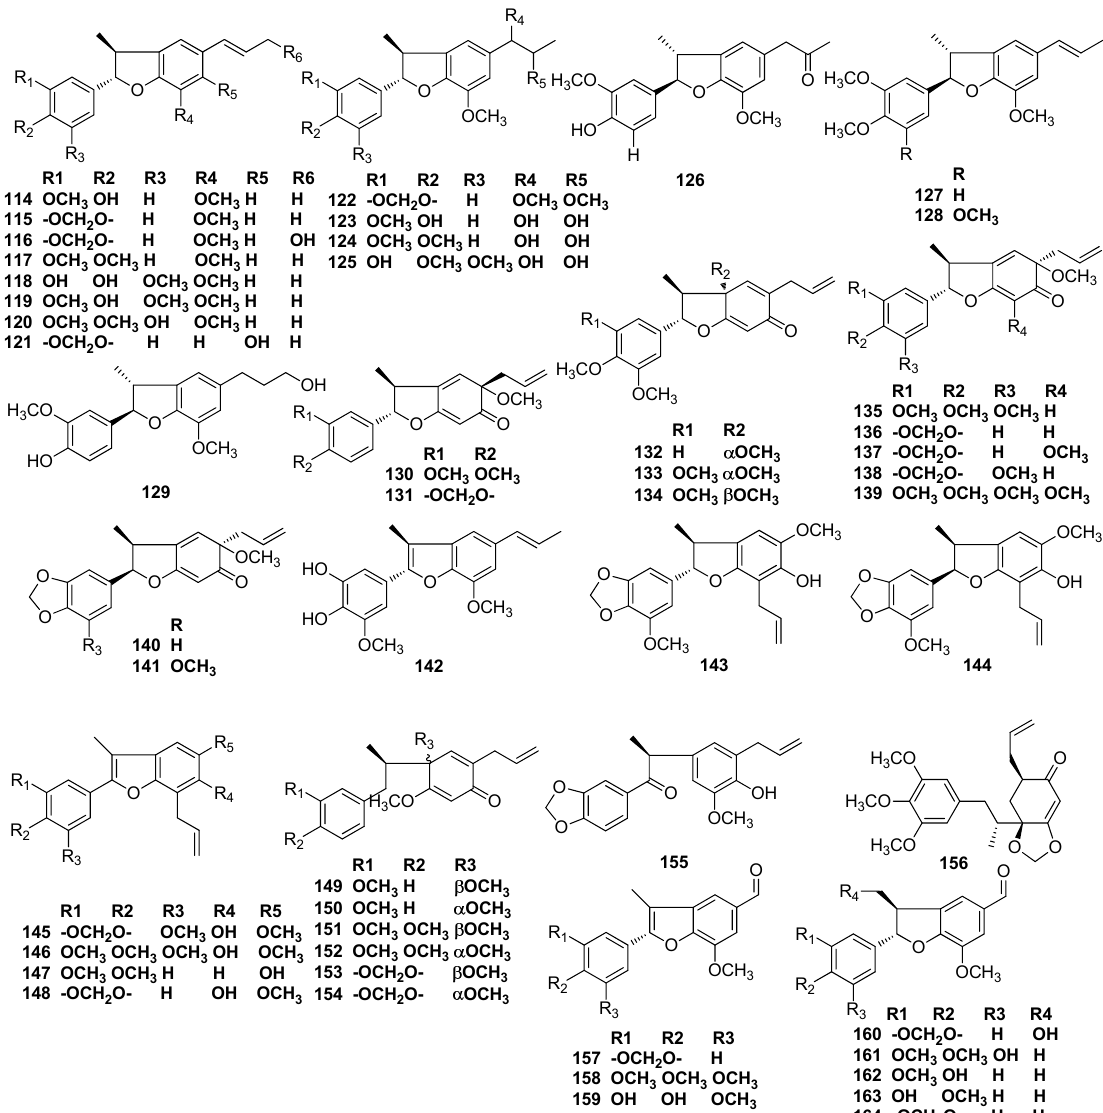
Figure 9. Chemical structures of 8,3’-neolignans.